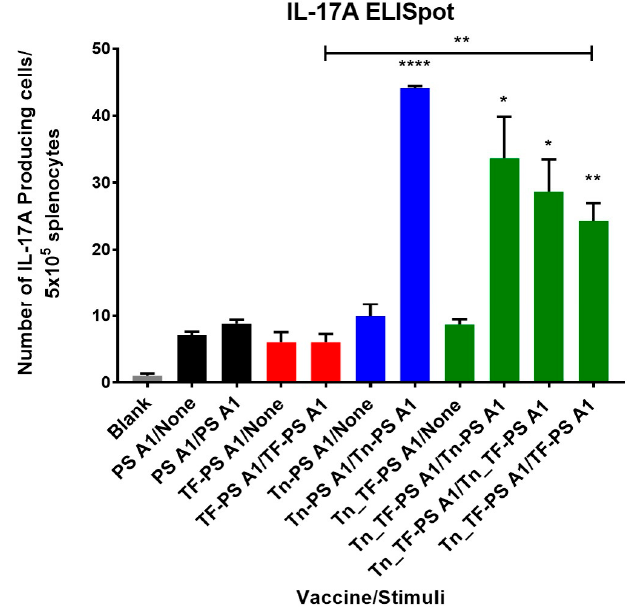
Figure 5. IL-17 ELISpot response from unstimulated and stimulated murine splenocytes obtained from mice immunized against the respective TACA-PS A1 constructs. Error bars are shown as mean ± standard error of mean response between 3 mice, in which, each mouse was performed in triplicate. Where * p < 0.05, ** p < 0.01, **** p < 0.0001 by using two-tailed Student’s t -test between stimulated and unstimulated splenocytes.